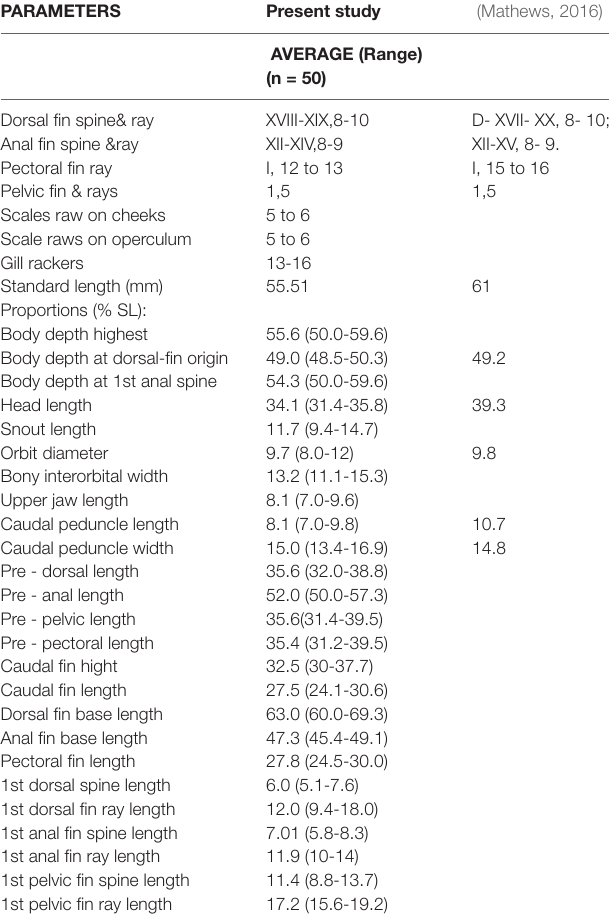
TABLE 3 | Comparison of the counts and morphometric data of P. maculatus collected from Korapuzha river, Calicut, Kerala with P. maculatus collected from Manimala river, Travancore, Kerala ( Mathews, 2016